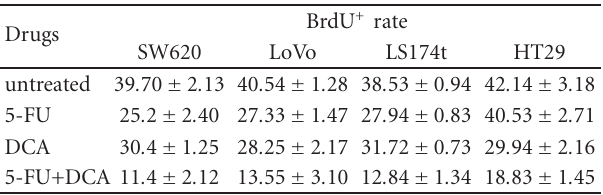
Table 2: SW620, LoVo, LS174t, HT29 cells, and 293T noncancerous controls were treated with 10mM DCA and 20 μ M 5-FU alone or in combination for 48hours, and then pulsed with BrdU. Cells were then harvested and stained, and the numbers of BrdU+ cells were calculated as the mean number of the positive cells in eight di ff erent fields of view in one image (magnification, 400X). This calculation was repeated three times. ∗ P < . 05, compared with control. BrdU + cells in di ff erent drug treatment (%, mean ±